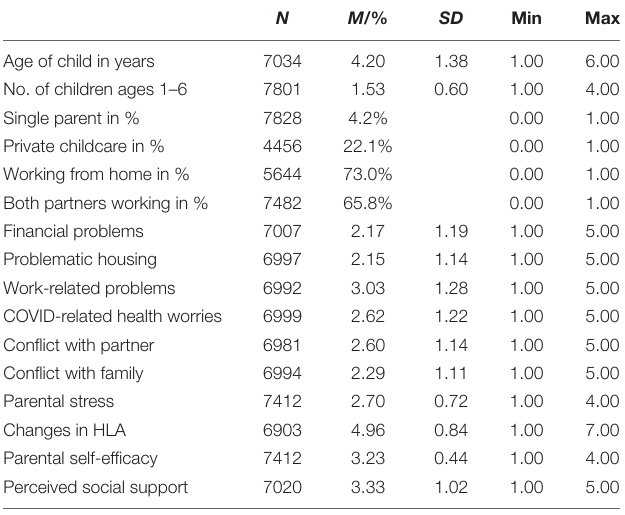
TABLE 1 | Descriptive statistics. TABLE 2 | Regression results for stressors predicting perceived